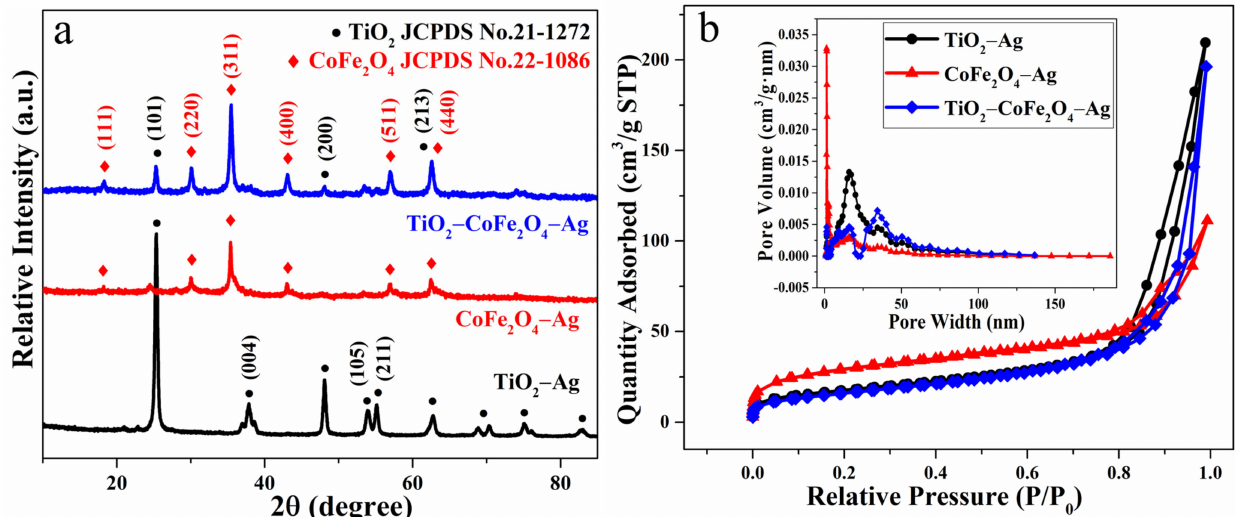
Figure 1. ( a ) X-ray diffraction (XRD) patterns and ( b ) N 2 adsorption–desorption isotherms, with pore size distributions (inset) of TiO 2 − Ag, CoFe 2 O 4 − Ag, and TiO 2 − CoFe 2 O 4 − Ag.